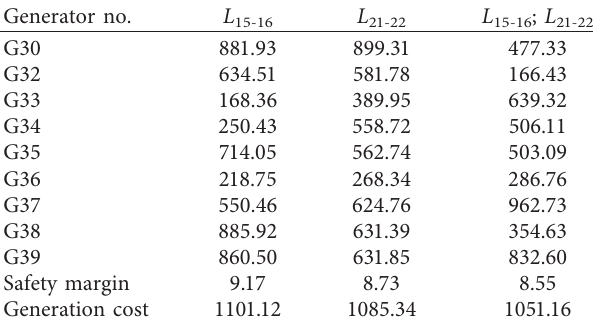
Figure 6: POF from initial failures L 15-16 . time. Table 4: Preventive control optimization results.